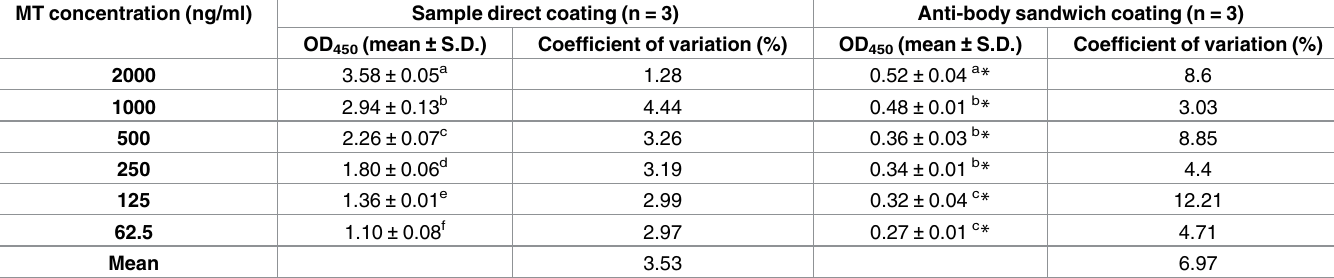
Values within a column having different superscript letters are significantly different and values within a line with “ * ” are significantly different ( p < 0.05). N means sample